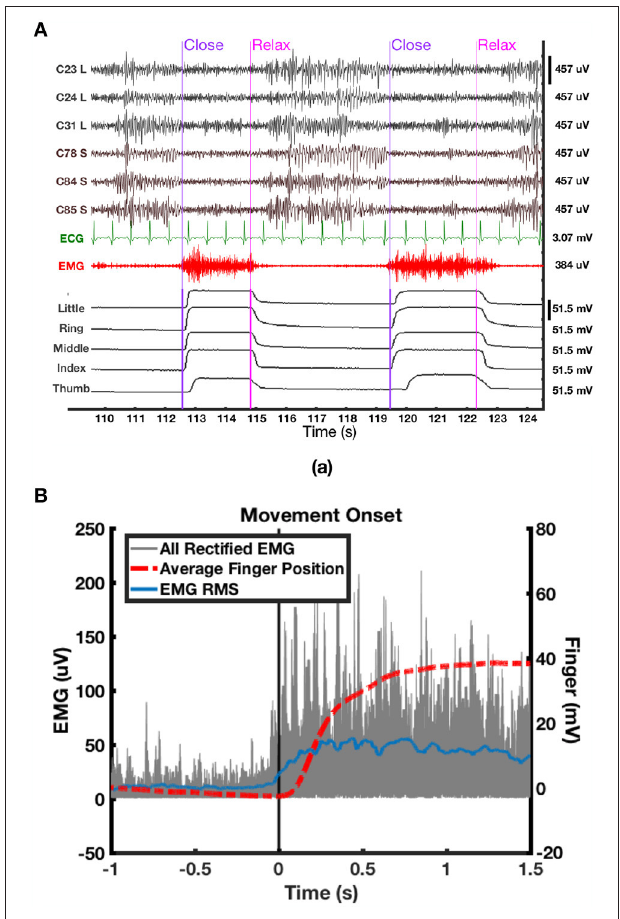
FIGURE 5 | (A) Synchronized epoch of data of ECoG, ECG, EMG, and finger positions data of P2. ECoG were high-pass filtered at 3 Hz, whereas EMG was high-pass filtered at 50 Hz for visualization. (B) Overlay of rectified EMG (gray) from uncorrupted trials, average of all five finger positions from the dataglove (red) and root mean square (RMS) average of rectified EMG